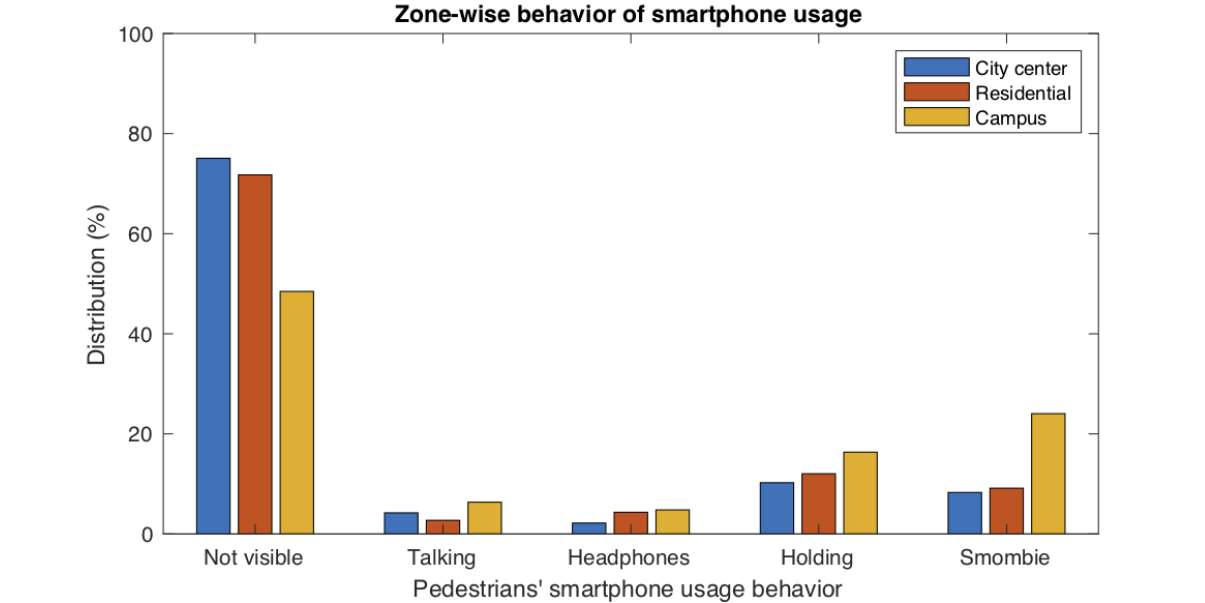
Figure 7. Smartphone usage behavior of pedestrians in different areas of a city. This figure shows the observational results (%) from Table 4.